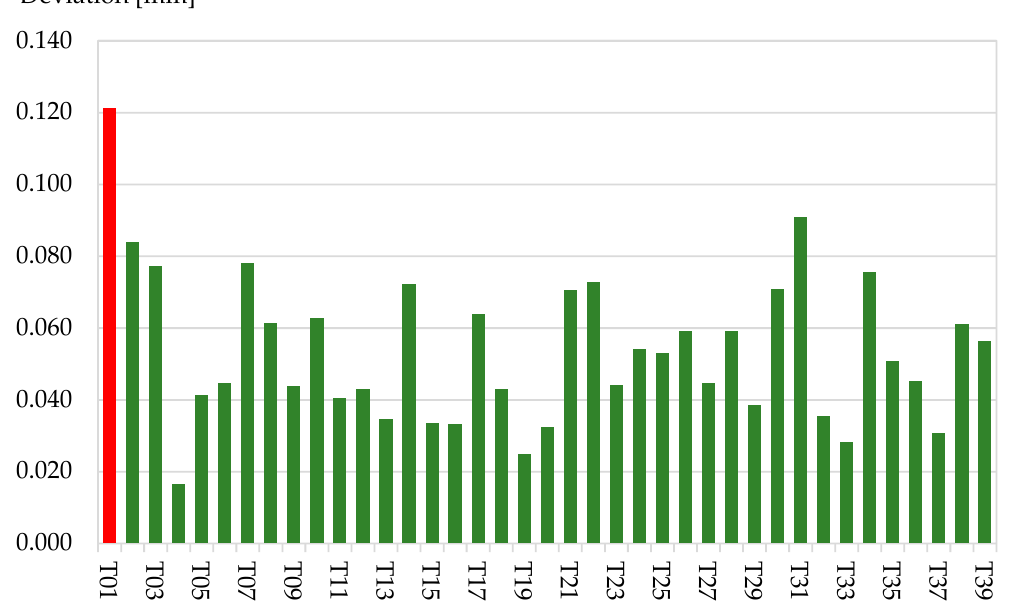
Figure 9. Deviation of target centre to reference point measured with laser tracker on CCR for the targets T01–T39 in [mm].